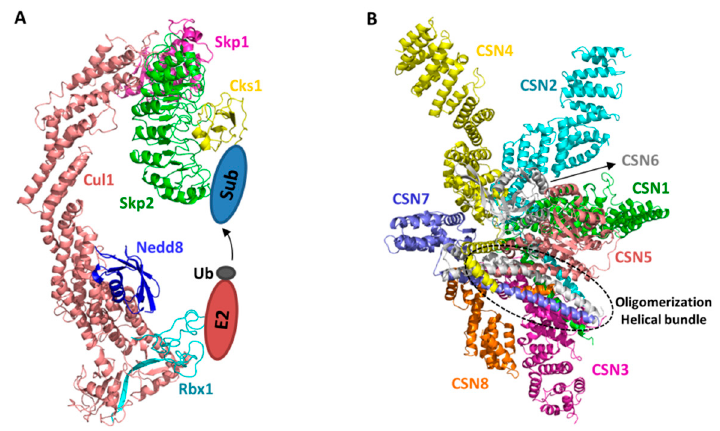
Figure 1. Structural models of a CRL (SCF Skp2 / Cks1 ) and the COP9 signalosome (CSN). Individual subunits are colored differently. The E2 and substrate locations are shown in the scheme. The helical bundle formed by the c-terminal helix of all eight CSN subunits is highlighted in circle ( A ). The SCF Skp2 / Cks1 complex is built as previously described [24], based on the crystal structures of SCF Skp2 [29], Skp1-Skp2 / Cks1 [31], and Nedd8-Cul1 1-690 [21]. The CSN model is a representation of a previous published crystal structure (PDB id: 4D10) [32] ( B